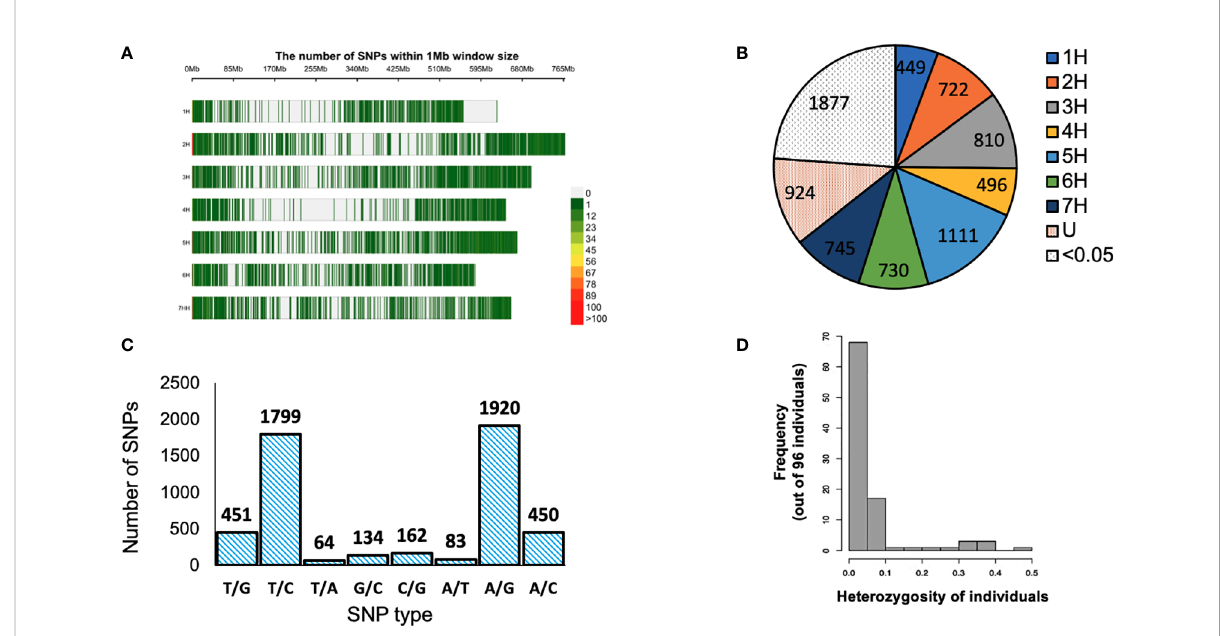
FIGURE 1 (A) Distribution of single nucleotide polymorphisms (SNPs) in the 9K Barley In fi nium iSelect SNP assay. U: markers with unknown positions SNPs with MAF of <0.05. (B) Distribution of SNP markers obtained high quality fi ltration on the barley genome based on the physical map. Color legend on the right shows the marker density. (C) SNP type for 5063 SNP markers used in the analysis. (D) Structure of heterogeneity detected in 96 barley genotypes > < 0.5.